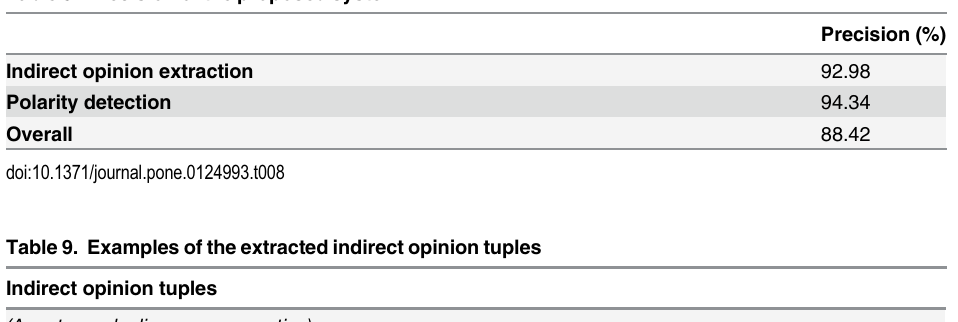
Table 8. Precision of the proposed system